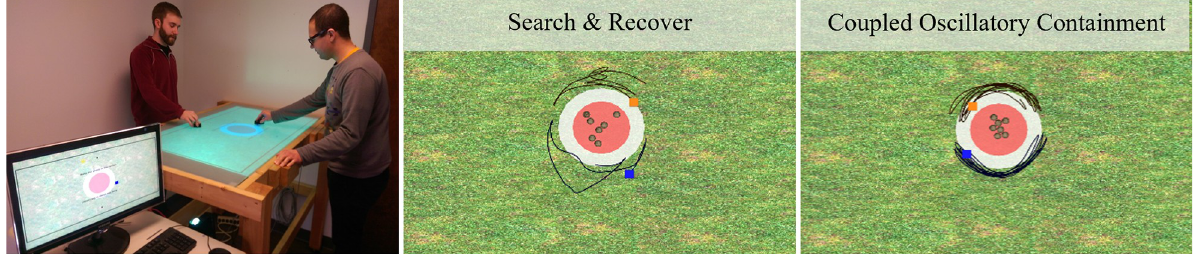
Fig 1. Experimental setup and behaviors observed in [11]. Participants stood on either side of a projected video display while holding motion sensors which moved their respective herding agents (HAs; the blue and orange square in middle, right panels). At the start of the experiment, participants would sub-divide the task-space to pursue and retrieve target agents (TAs; the brown spheres in middle, right panels) and then keep them contained within the specified circular containment region. Containment was enforced by chasing and retrieving individual escapees back into the region. This strategy is referred to as search and recover (S&R) behavior (center panel). Some dyads learned that a far more effective containment strategy was to coordinate oscillatory movements about the TA herd to keep them immobilized. This strategy is referred to as coupled oscillatory containment (COC) behavior (right panel). See text for more